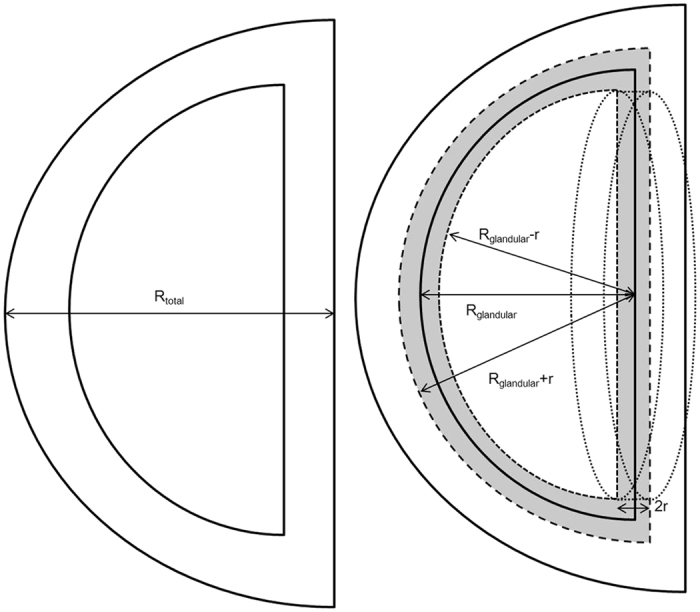
Schematic of a hemispheric breast.The light gray area indicates the interface zone surrounding the fat-gland interface. Rtotal = radius of the total breast, Rglandular = radius of the glandular tissue, r = size of the interface zone.